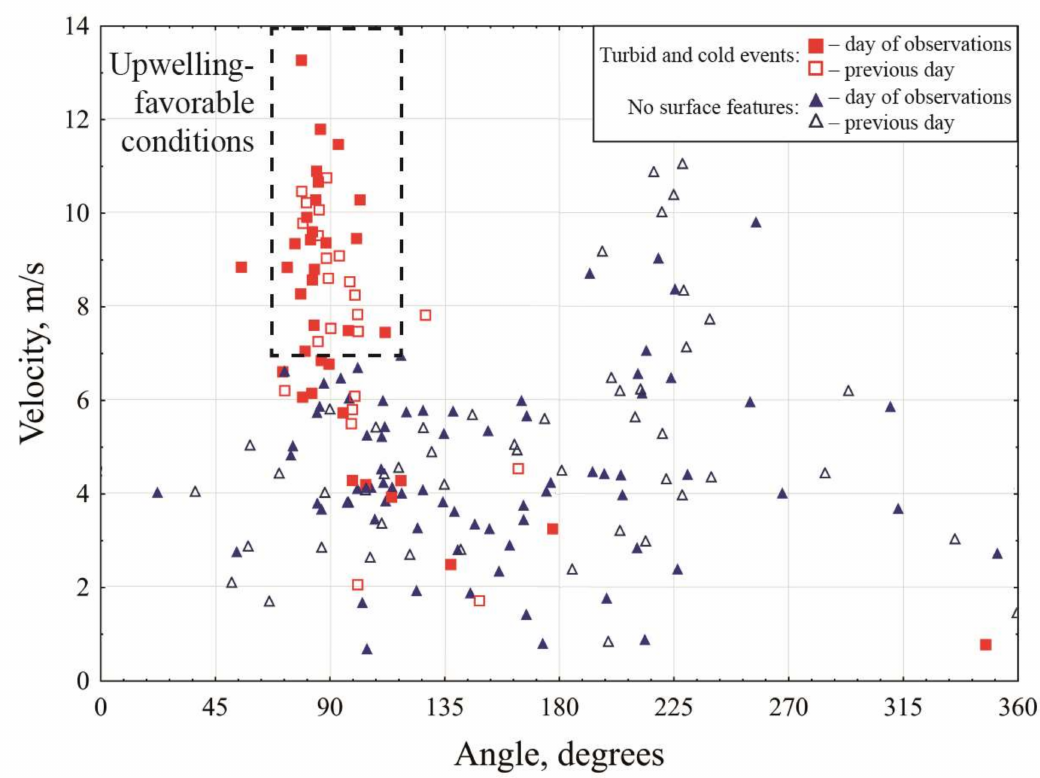
Figure 8. Wind forcing conditions at the Kolyma Delta region during periods of presence (red squares) and absence (blue triangles) of cold and turbid events detected on satellite imagery. For each satellite image, averaged wind forcing conditions are shown during the day of satellite observation (filled symbols) and during the preceding day (empty symbols). The black dashed rectangle indicates upwelling-favorable wind forcing